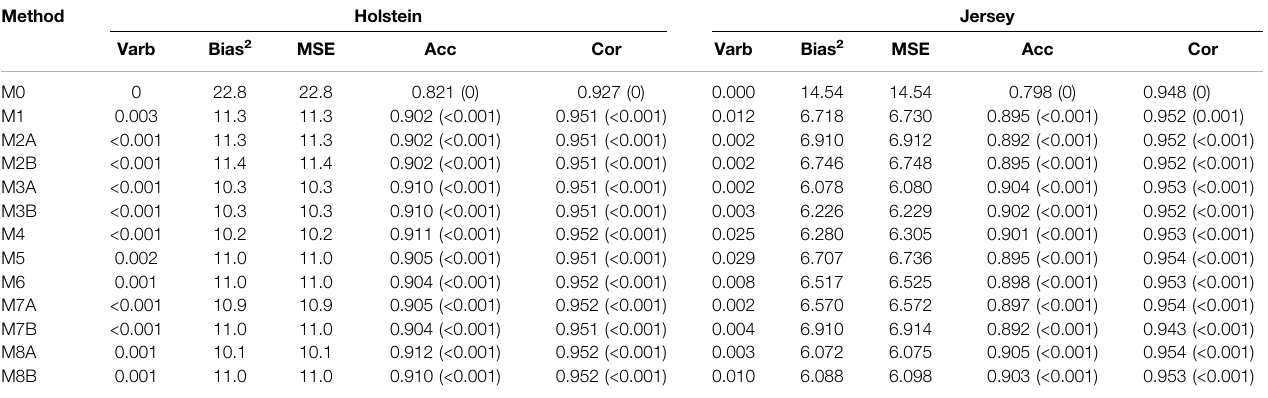
TABLE 3 | Decomposed mean squared error, R 2 accuracy, and correlation between estimated and actual daily milk yield obtained from 10-fold cross-validation a,b,c